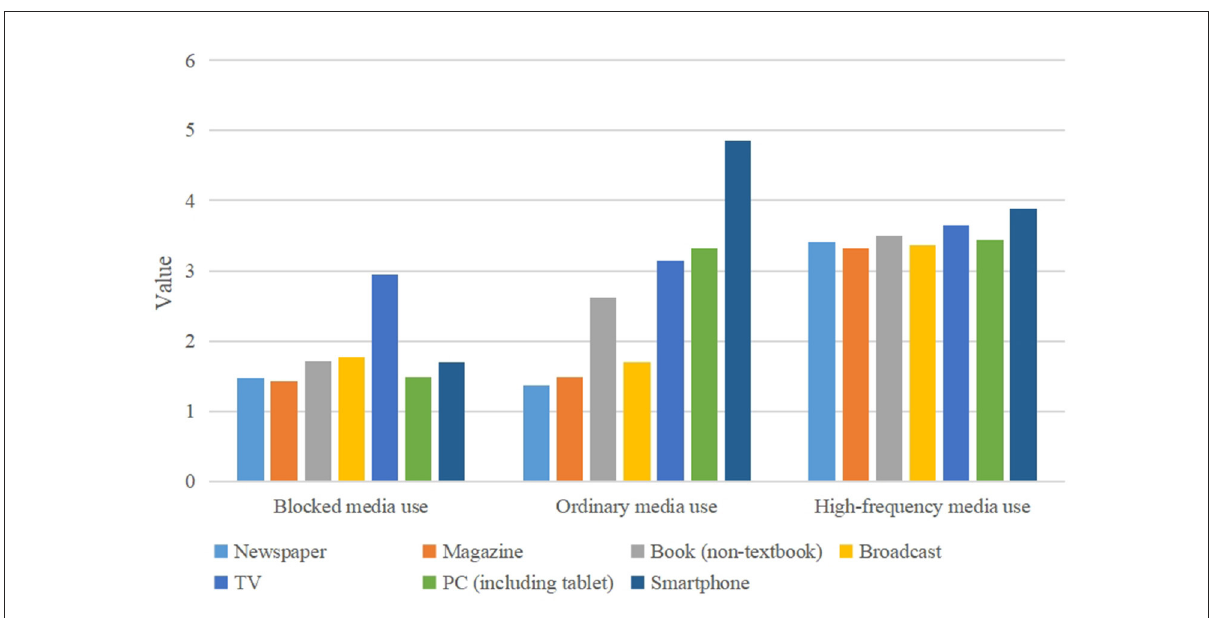
FIGURE1 Profile of three potential categories of residents’ media use of seven